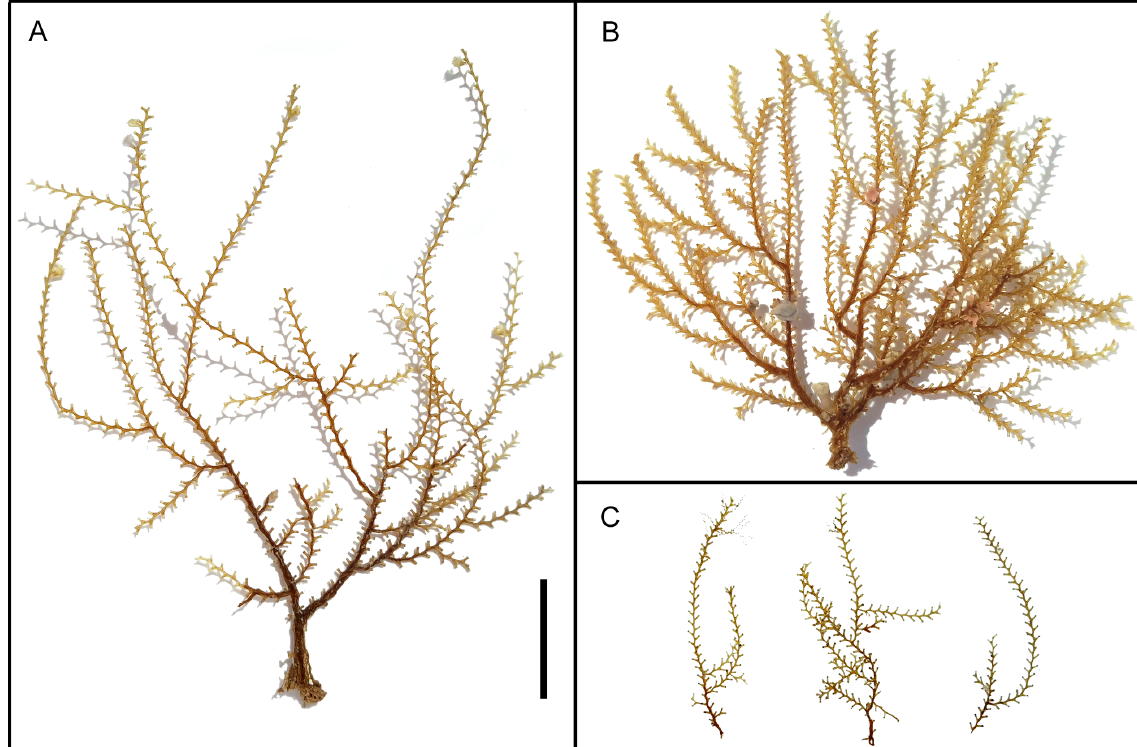
Fig. 2. A . ? Solenoscyphus striatus Galea, 2015, fertile colony from sample MNHN-IK-2015-364. — B . ? S. striatus , morphotype with approximated hydrothecae, sample MNHN-IK-2015-377. — C . ? Solenoscyphus subtilis Galea, sp. nov., paratype colony (left), MNHN-IK-2015-487; holotype colony (middle), MNHN-IK-2015-382; one colony from sample MNHN-IK-2015-488 (right). Scale bar: 2